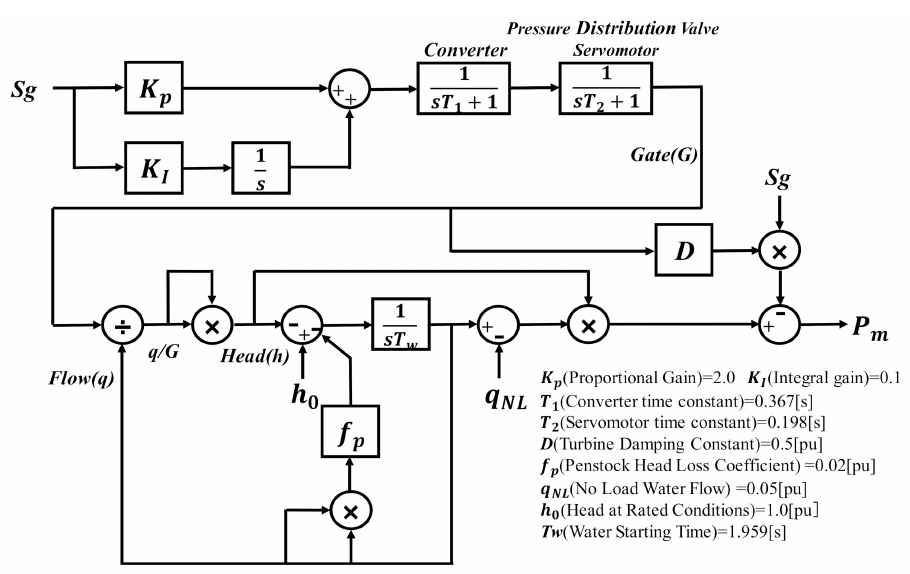
Figure 9. ASG water wheel governor model in generating operation